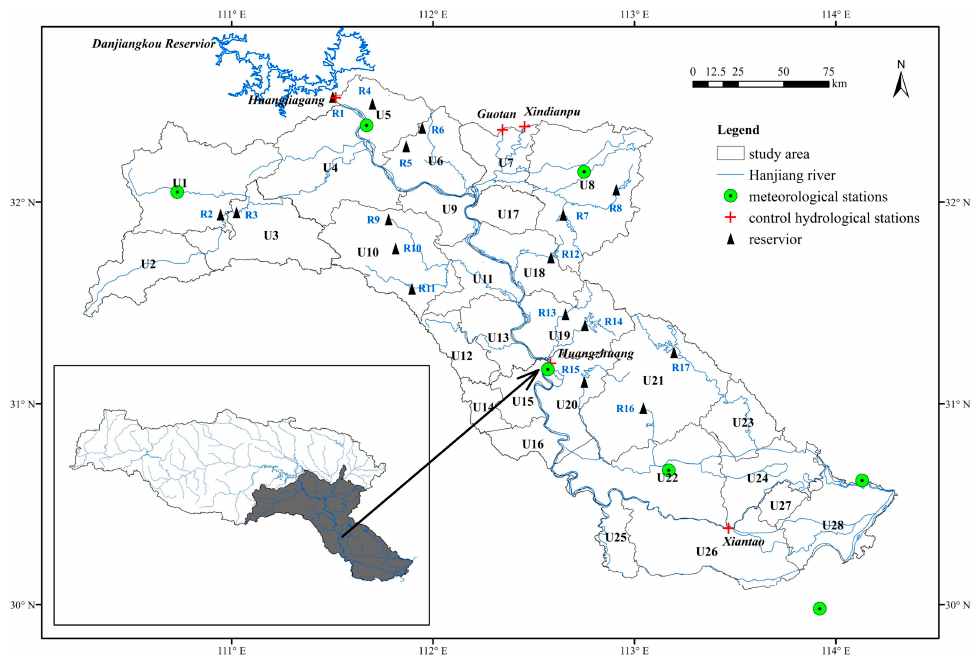
Figure 1. Location and hydrological stations in the Hanjiang River basin.